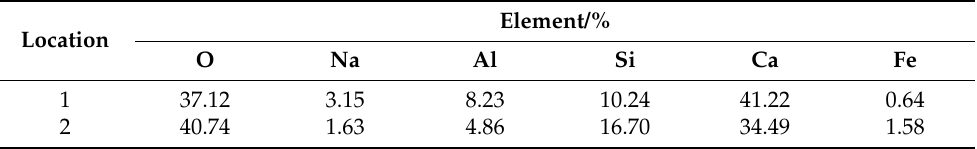
Figure 14. SEM pictures of BRM-cement ( A ), CBRM-cement ( B ), Tailings-cement ( C1 ) and EDS of Tailings-cement ( C2 ). Table 9. Percentage of elements in regions 1 and 2.